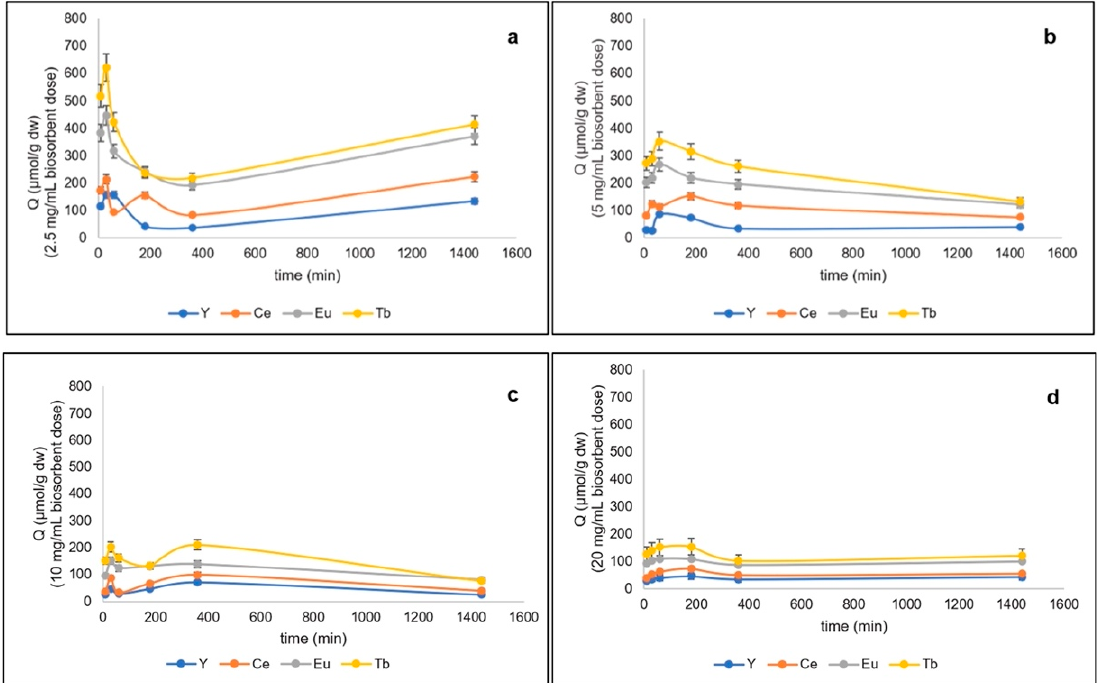
Figure 2. Total metals removed (µmol/g dw) from quaternary metal systems at pH 4.5 by freeze- dried algal biomass of G. sulphuraria ACUF427 at different doses of biosorbent: ( a ) 2.5 mg/mL, ( b ) 5 mg/ mL, ( c ) 10 mg/mL, and ( d ) 20 mg/mL after 10, 30, 60, 180, and 360 min of contact time. The highest amounts of Eu 3+ removed were 447.23 ± 38.51 µmol/g at the lowest were 214.03 ± 19.58 µmol/g at the biosorbent dosage 2.5 mg/mL (Figure 2a). Even at pH 4.5, the best removal rates were recorded at 2.5 mg/mL; terbium (621.16 ± 5.21 µmol/g of